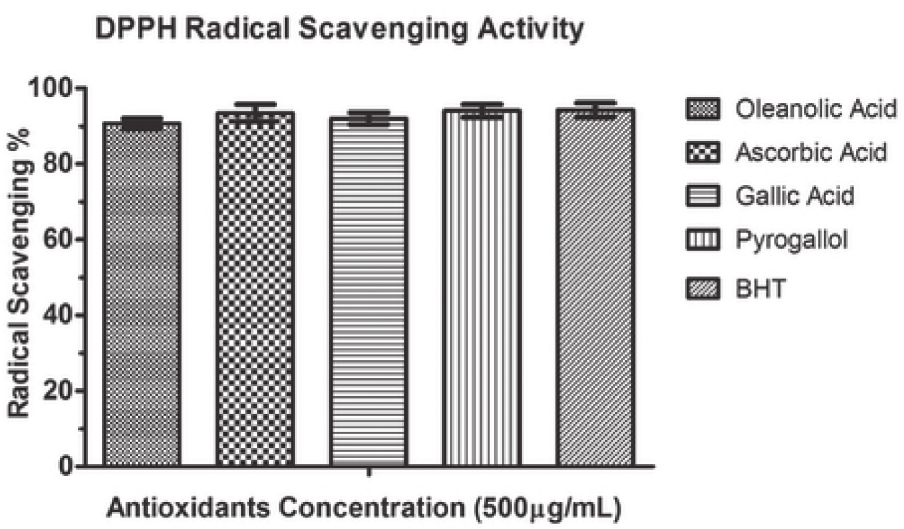
FIGURE 3 - Antioxidant activity (DPPH method) of oleanolic acid.